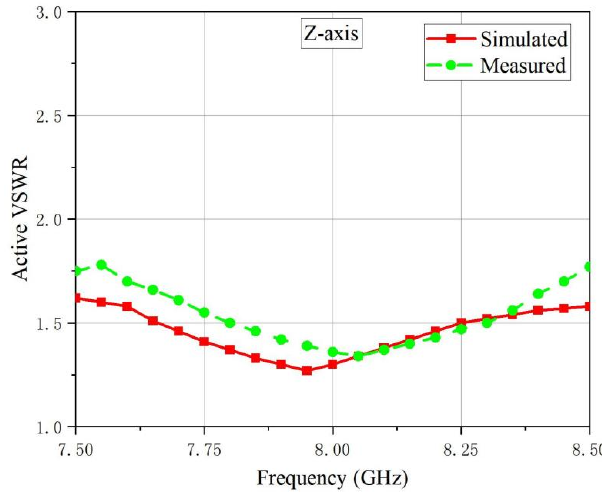
Figure 15. The active VSWR of the Z ‐ axis direction.